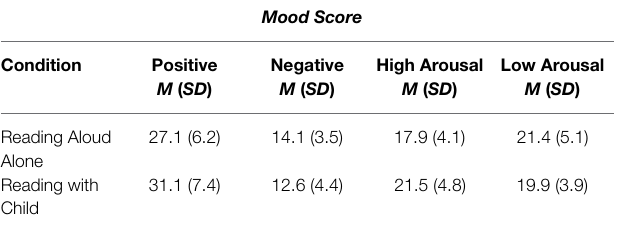
TABLE 2 | Postsession Mood Scores for Each Condition in Experiment